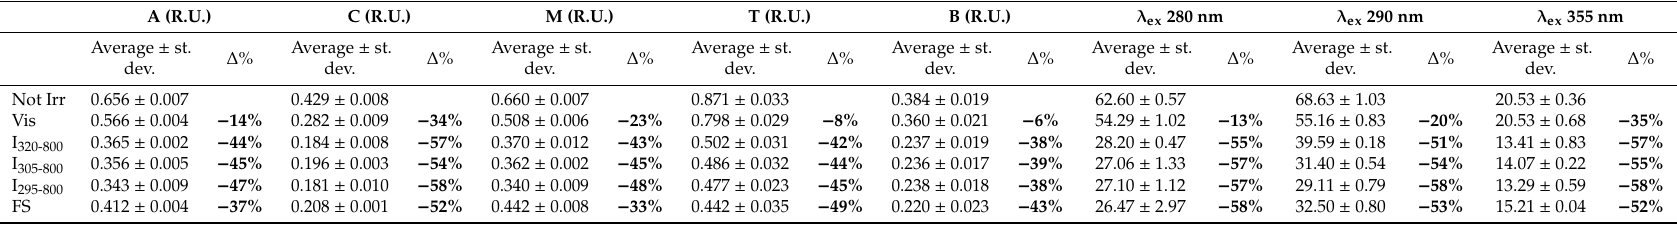
− 37% 0.208 ± 0.001 32.50 ± 0.80 − 53% 15.21 ±